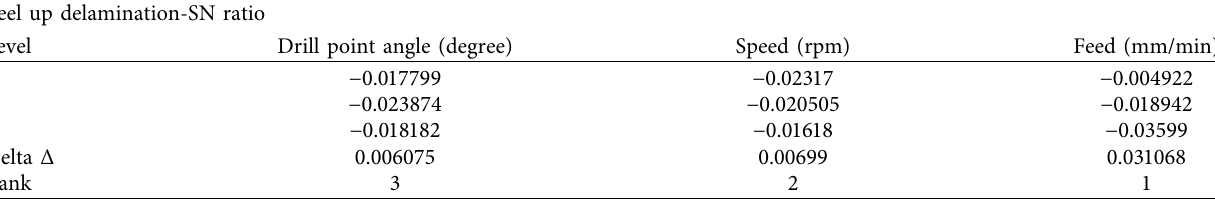
Table 4: Signal-to-noise ratios response table.